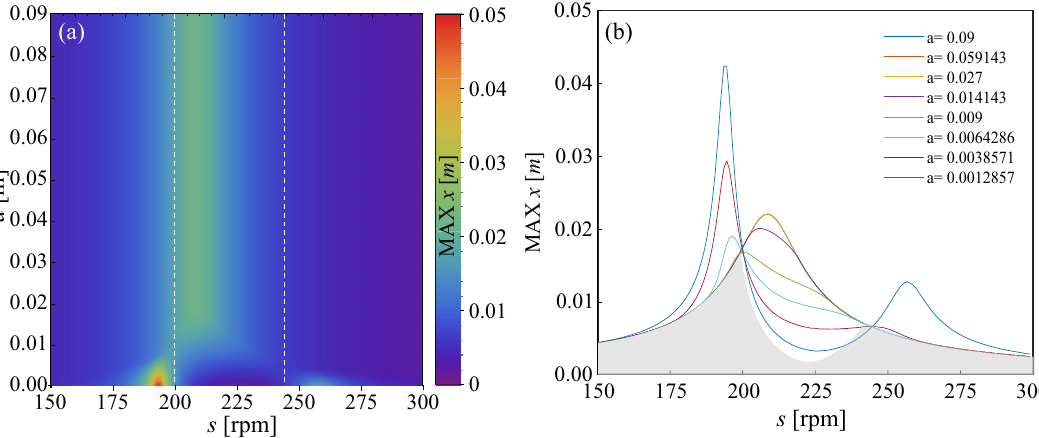
Figure 9. In panel ( a ), we show two dimensional plot of maximum amplitude of damped system (max x [ m ] ) in two parameters space: a and s for damping function given by equation (Equation (9)). Panel ( b ) shows eight exemplary FRCs of damped